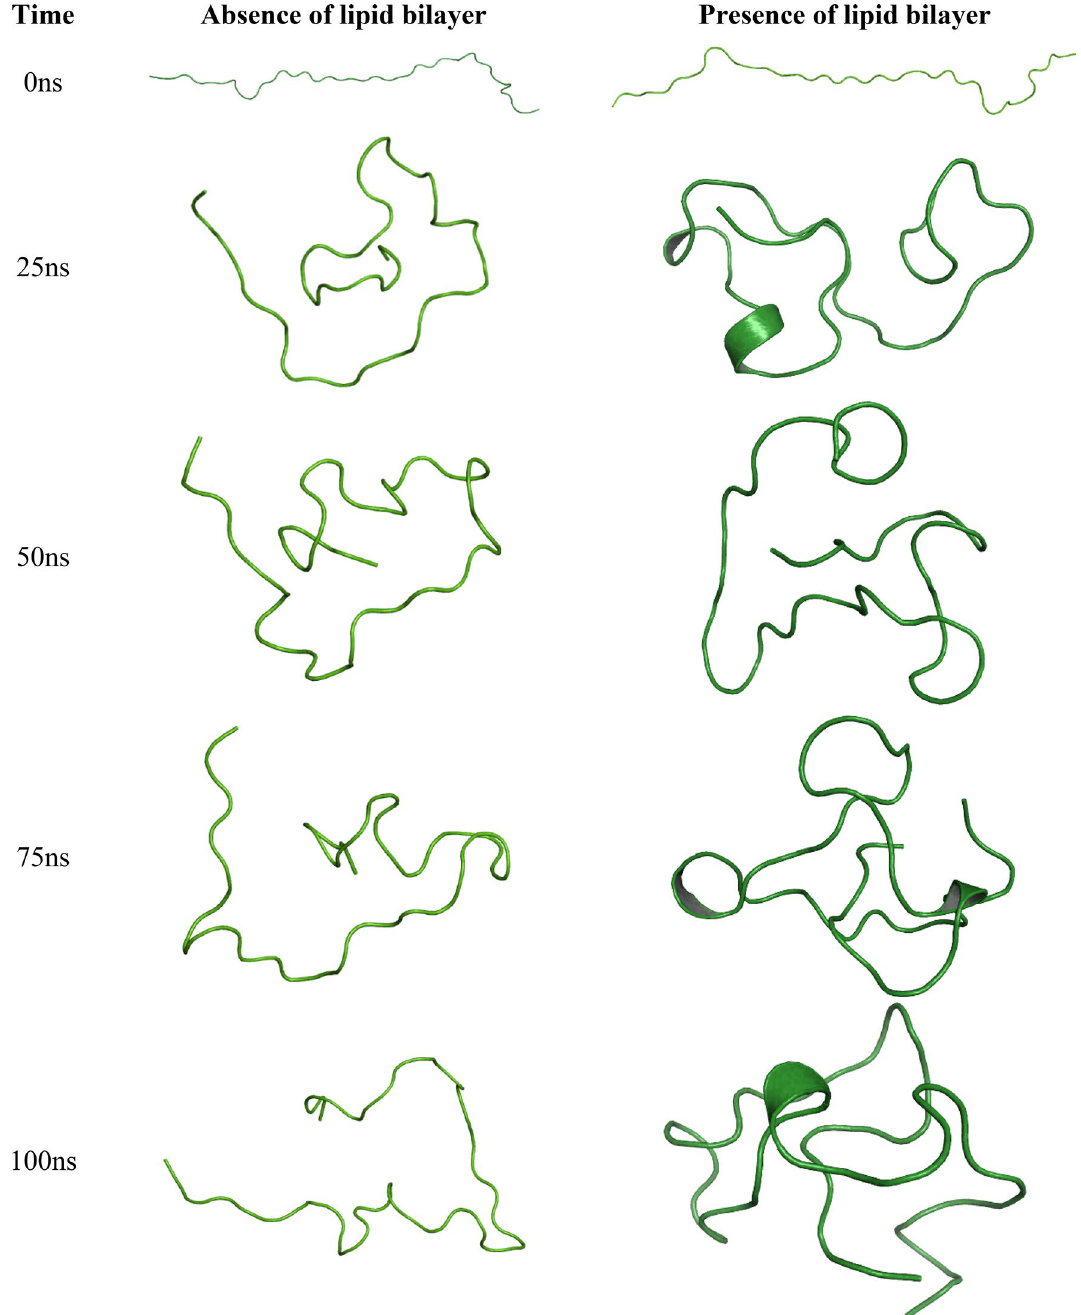
Figure 11. Simulation time-based progression of SSTR2 C-terminal domain in the presence and absence of lipid bilayer. The domain formed more secondary structure elements in the presence of